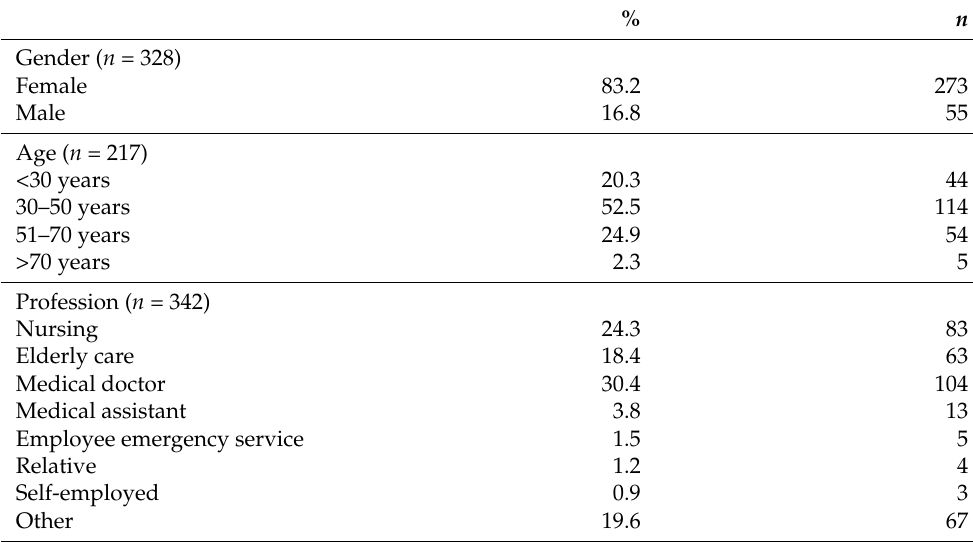
Table 1. Structure of the sample.